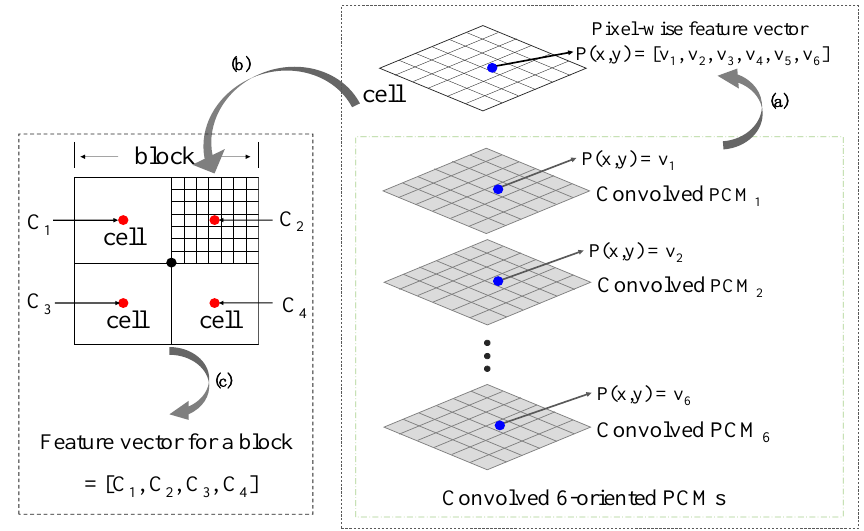
Figure 6. The process of constructing the feature vector for a block. ( a ) Compute the pixel-wise feature vector using the convolved PCMs. P(x, y) means the feature vector of the pixel in location P(x, y), and the vector size is 1 × 6; ( b ) obtain the central pixel’s feature vector of each cell. C 1 , C 2 , C 3 , and C 4 are the corresponding centric pixel’s feature vectors of the four cells; ( c ) Combine the four feature vectors to obtain the conjoint feature vector for a block. The feature vector size of the block is 1 × 24.